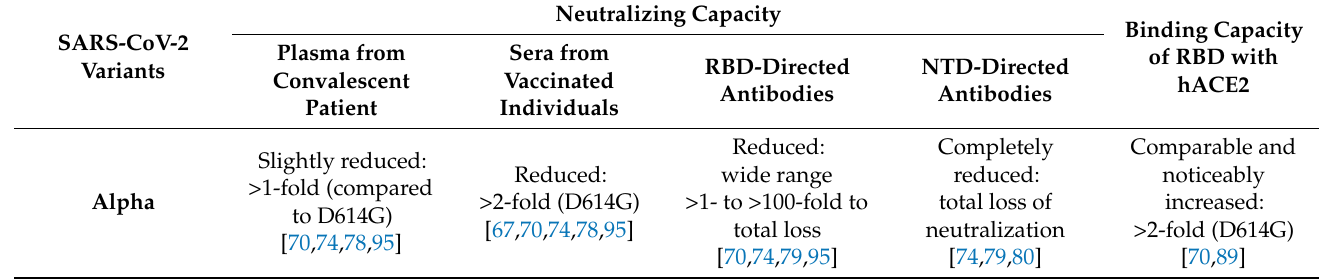
Table 1. Susceptibility of SARS-CoV-2 VOCs to neutralization. The overall trends and changes of antibody neutralization capacity against different variants and binding capacity of RBD with hACE2 are listed in the table. The referred S strain is enclosed inside parentheses. The extent of reduction or increase varies significantly across different literatures, due to the differences of characterization assays (virus-based, cell-based, and protein-based) and the variability of samples (sera, plasma, virus, antibodies, S ectodomain, or S RBD). The results are limited to literatures discussed in this review. We are aware of the discrepancy and even inconsistency in different research